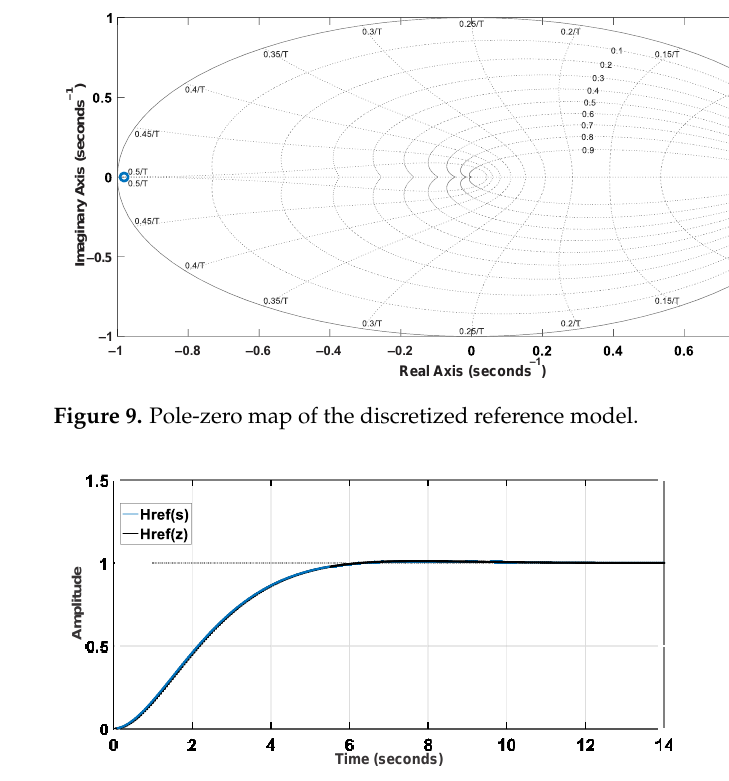
Figure 8. Pole-zero map of the reference model in the continuous domain.